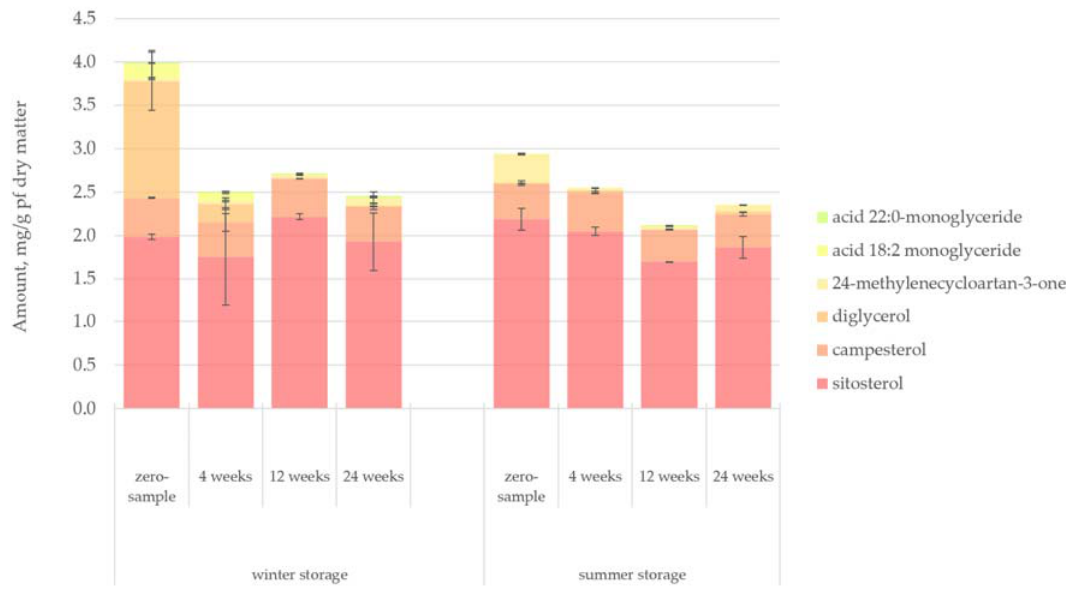
Figure 9. Changes in sterols during summer and winter storage periods of saw log bark.